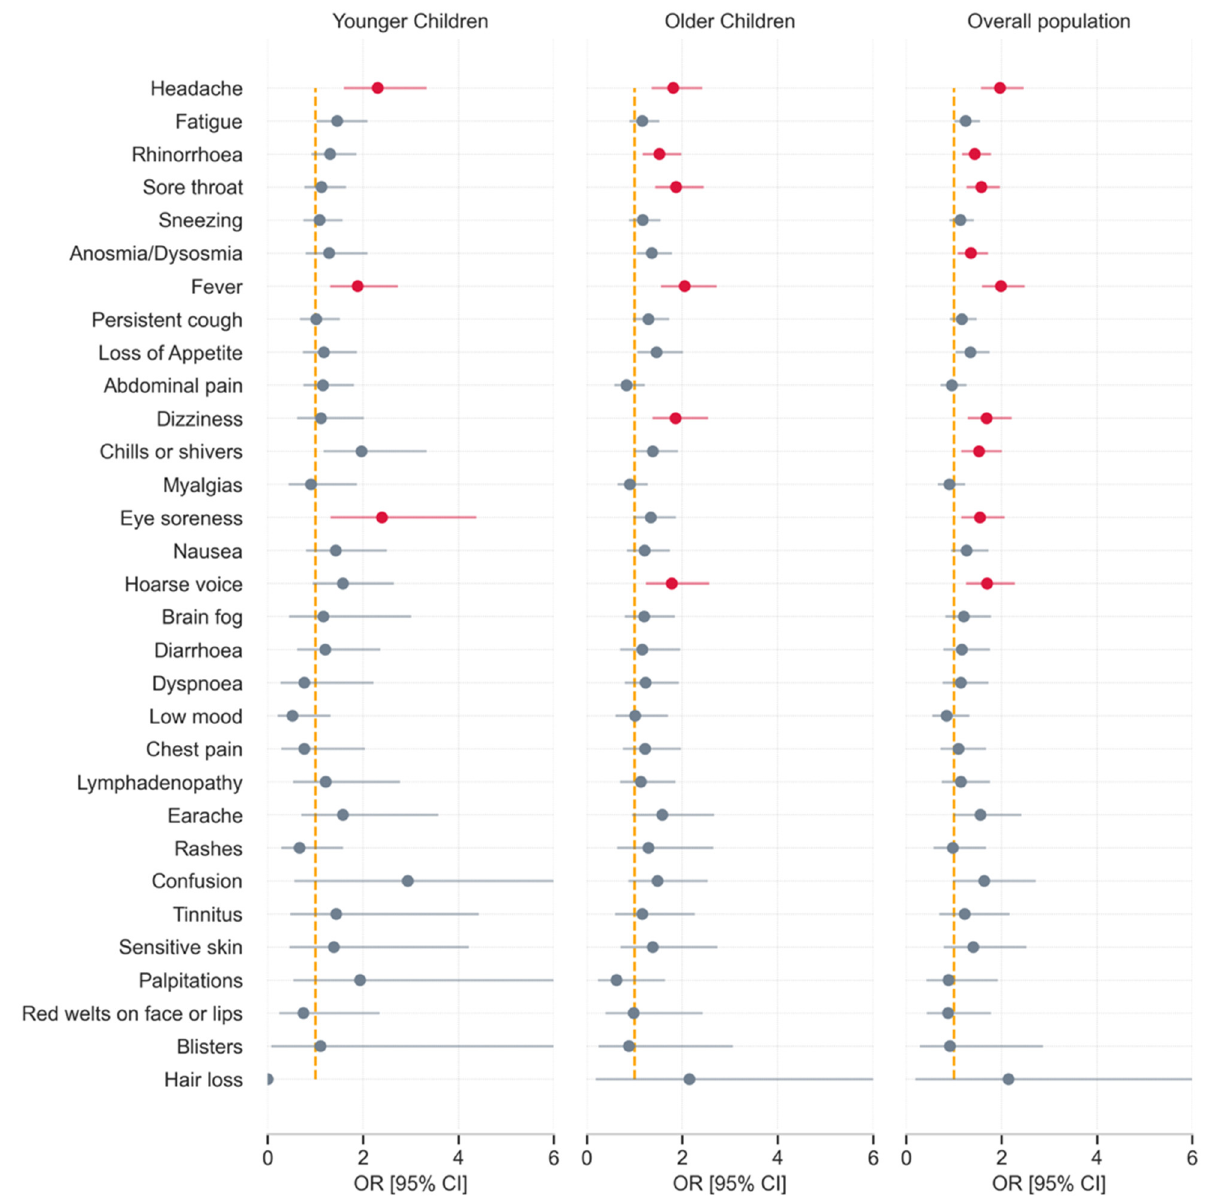
Figure 3. Odds ratios for a symptom presenting within the first 28 days of illness in children with COVID-19 during periods of SARS-CoV-2 Delta vs. Alpha variant predominance. Results for younger (5–11 years) and older (12–17 years) children, and for the cohort overall, comparing symptom prevalence during Delta with prevalence during Alpha infection, and adjusted for age and sex. Results with statistical significance after false discovery rate test ( α < 0 · 05) are in red. Individual symptom duration was short (median 5 days) (Figure 4). The symptom of longest duration was ‘blisters’ (particularly in younger children with Alpha infection); however, the prevalence of blisters was extremely low (approx. 1%) (Supplementary Table 3).